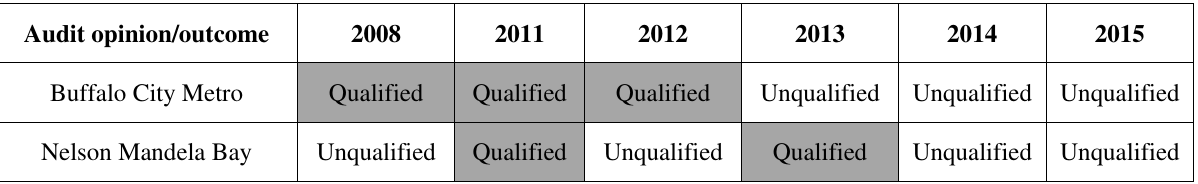
Table 1. A five (5) year audit opinion